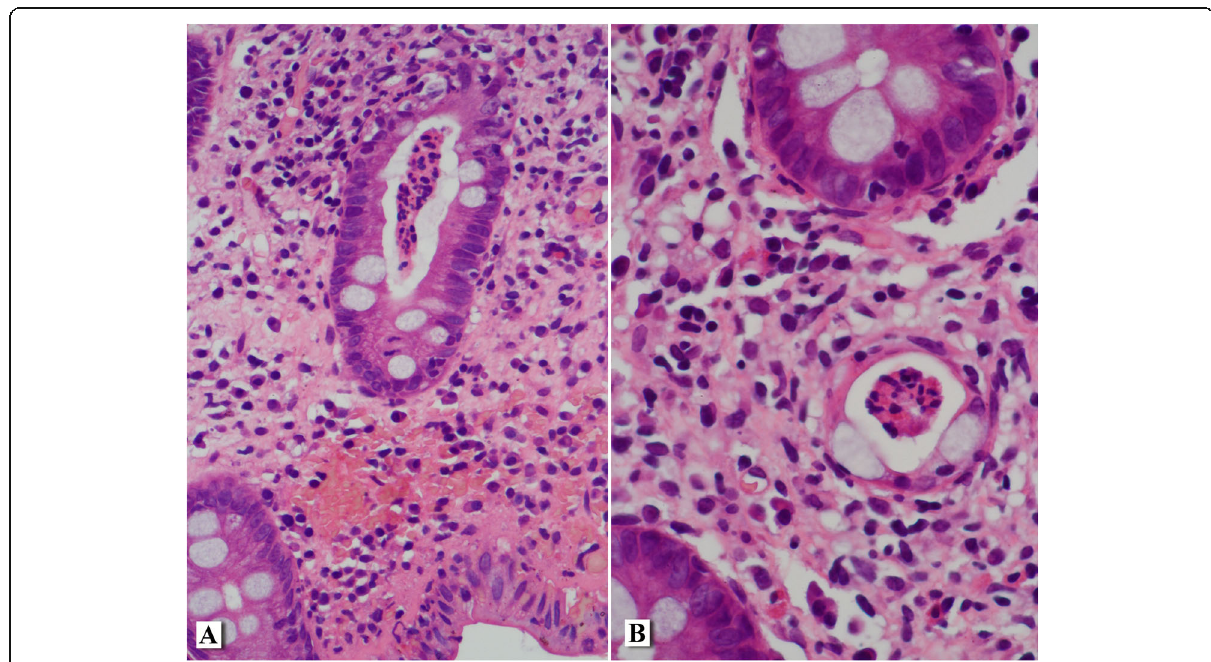
Fig. 2 Rectal biopsy showed inflammatory changes – photomicrographs showing crypt microabscesses. A (100x) and B(400x), HE